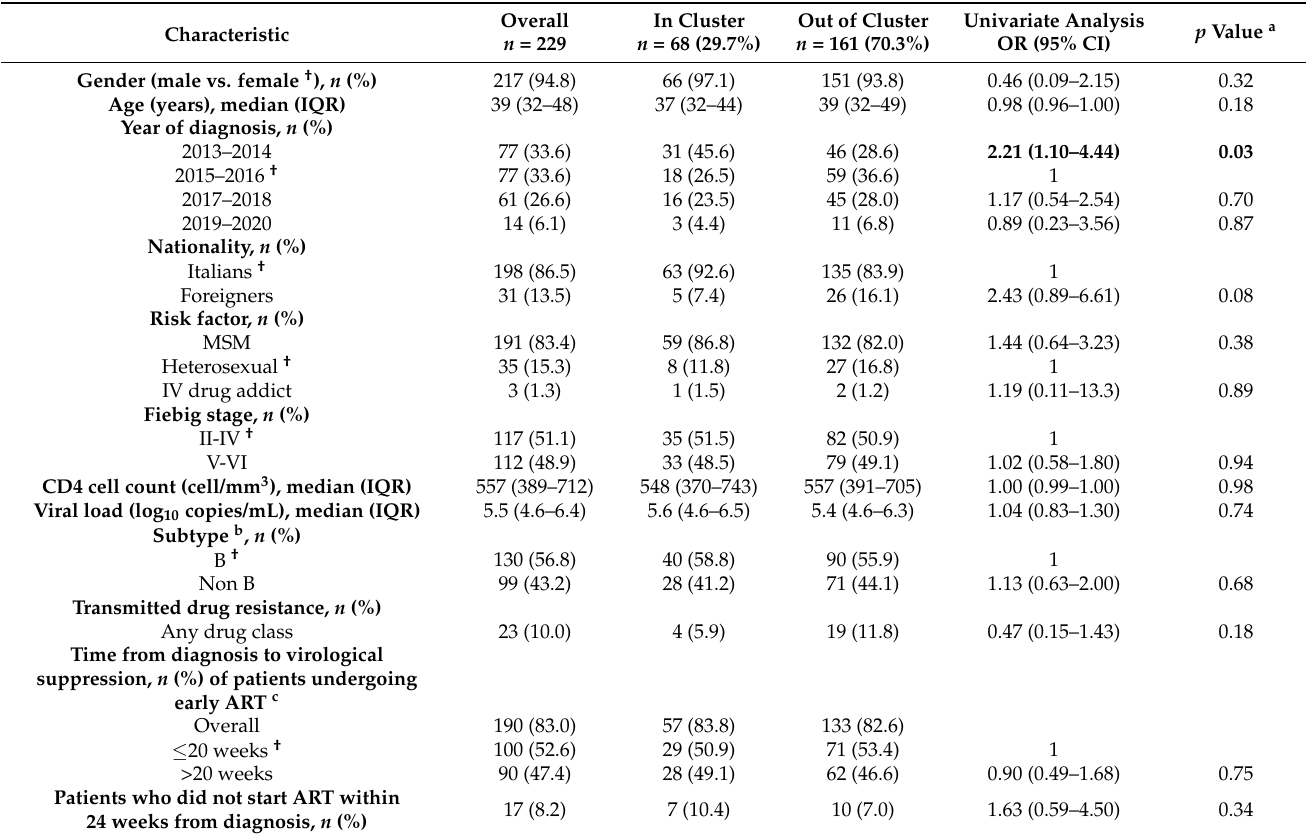
Table 1. Primary HIV infection (PHI) patient’s characteristics and factors associated with HIV-1 TC.